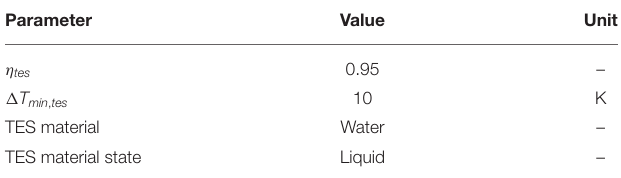
TABLE 4 | R1233zd(E) thermophysical